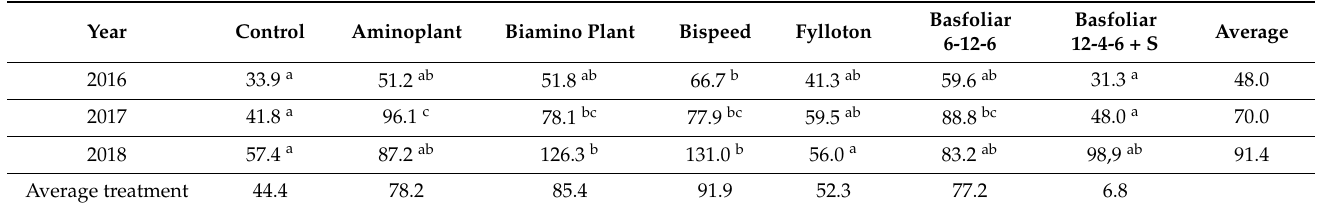
Table 6. The total leaf area of M.9 rootstock stoolings depending on the tested treatments (dm 2 ).